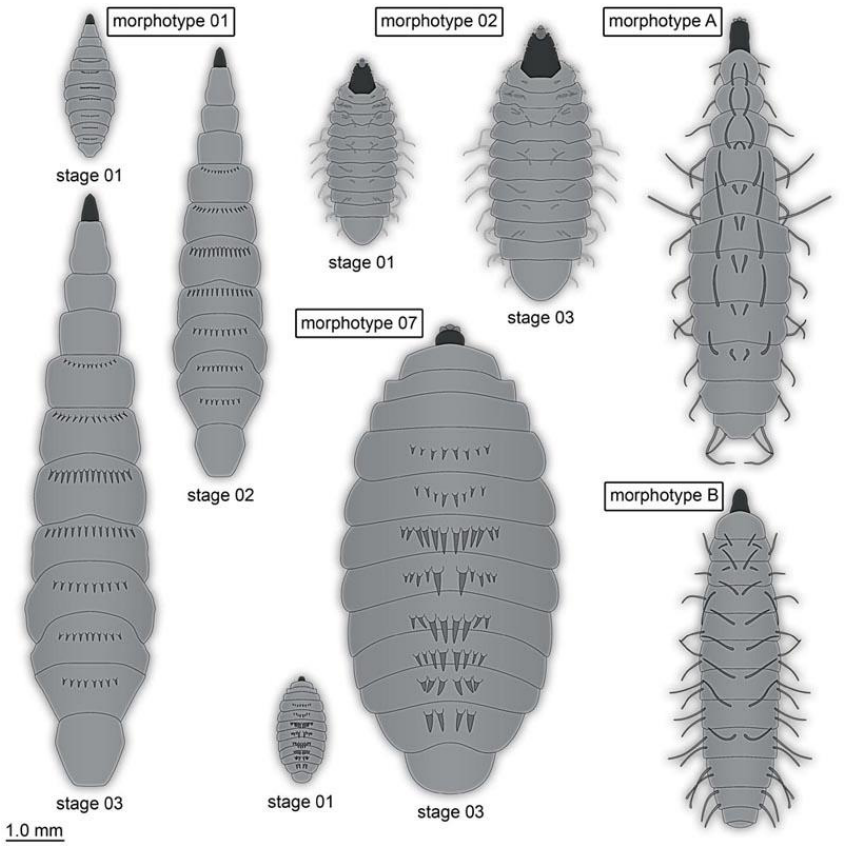
Figure 27. Restorations of all known types of fossil stratiomyomorphan larvae. Morphotypes 1, 2 and 7 based on specimens in this paper. Morphotypes A and B based on [12].